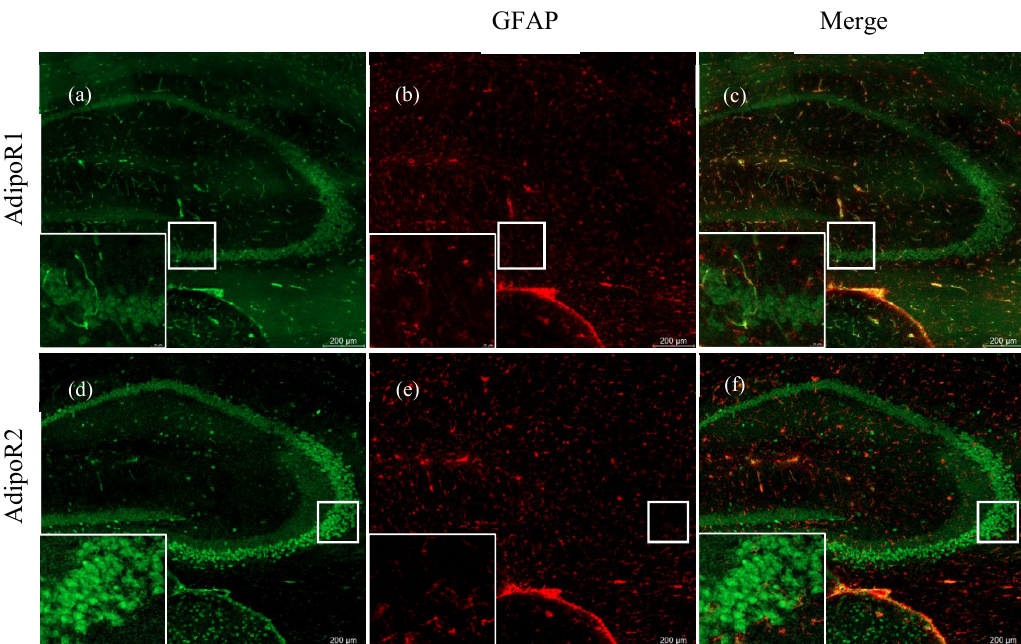
Figure 2. AdipoR and glial fibrillary acidic protein (GFAP) expression in hippocampi of 48–52-week-old wild-type mice. Hippocampal expression of glial fibrillary acidic protein (GFAP) in astrocytes of 5XFAD mice are shown in the middle panels ( b and e ). AdipoR1 is expressed in the hippocampus in both neuronal and endothelial cells ( a ). There is no colocalisation of AdipoR1 with GFAP in astrocytes ( c ). AdipoR2 is widely expressed in the hippocampal neurons ( d ), but it is not expressed in astrocytes ( f ). Images were acquired at 20x magnification. Scale bars for ( a )–( f ) are 200 μ m. Scale bars for zoomed-in figures are 20 μ m.